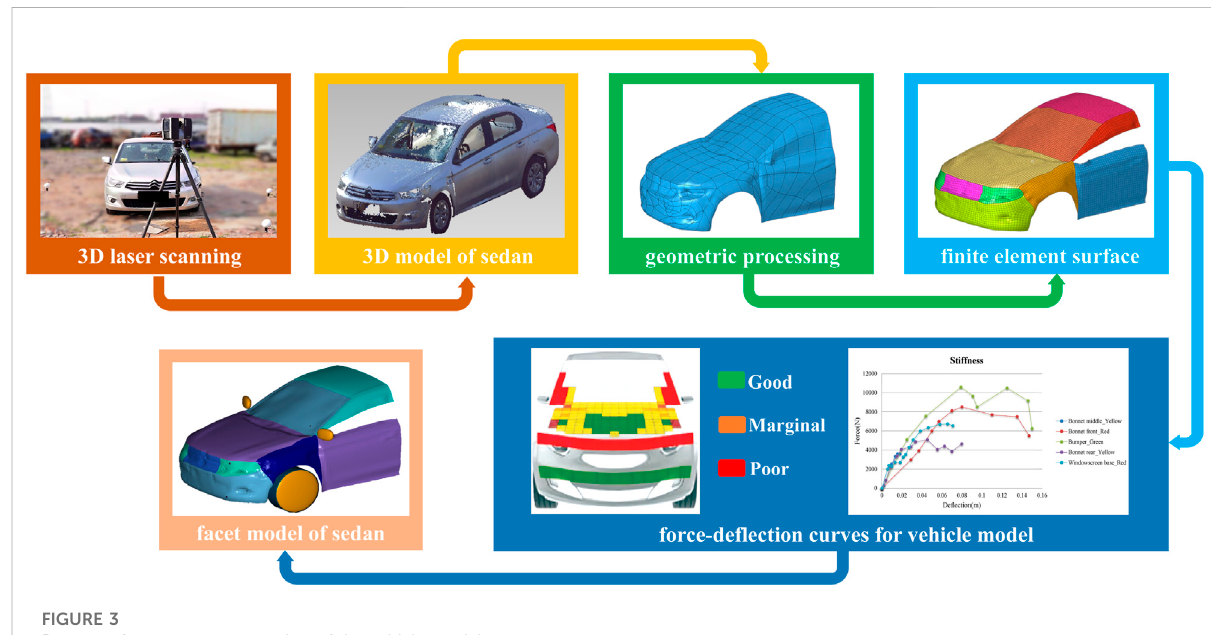
FIGURE 3 Process of reverse reconstruction of the vehicle